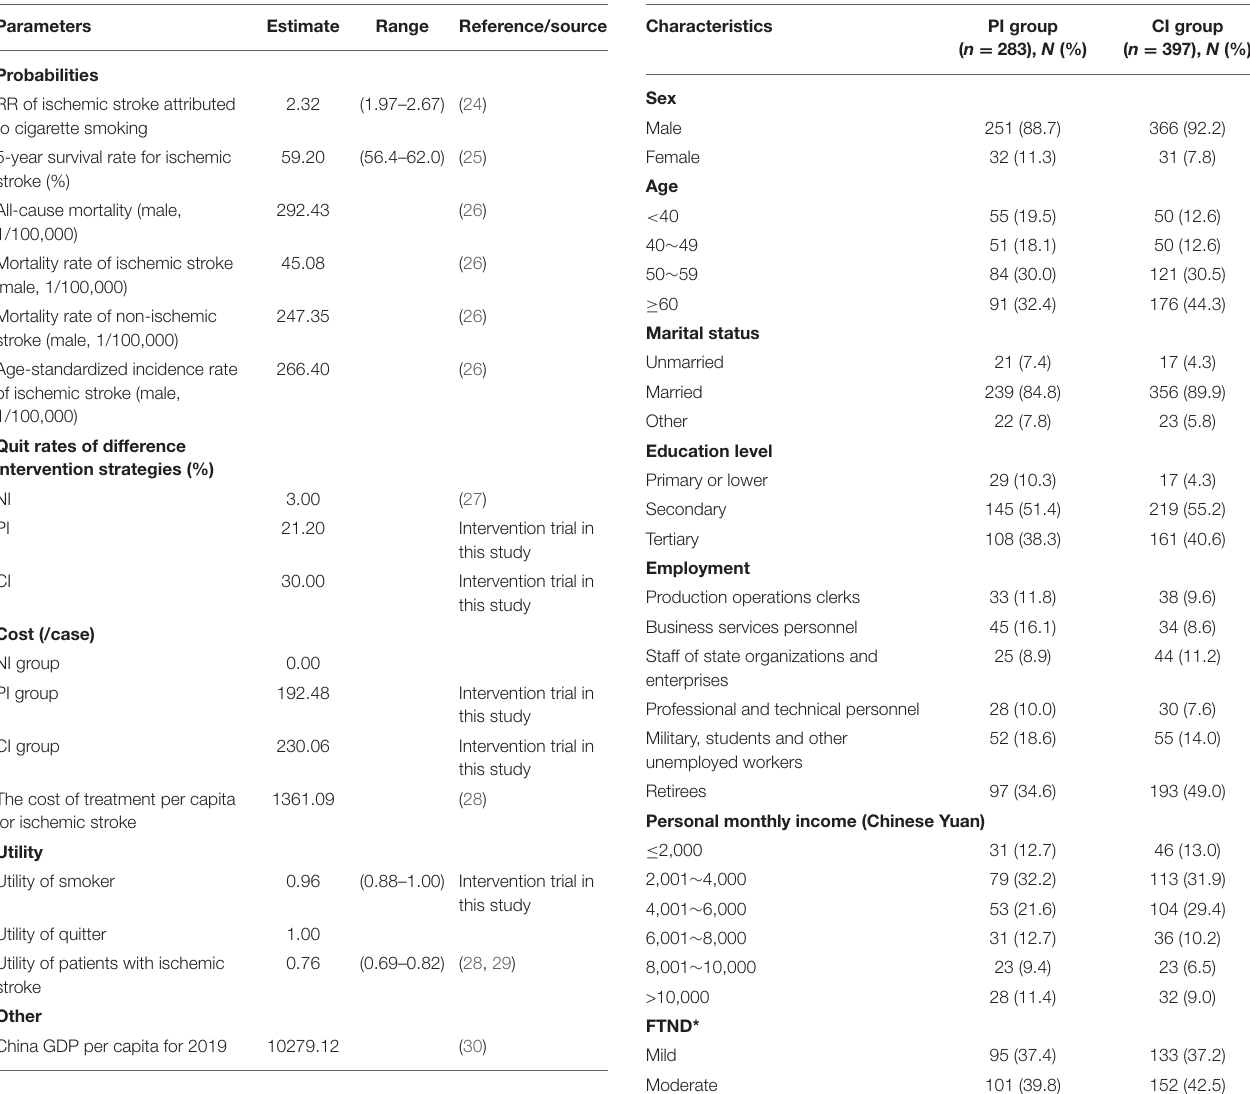
TABLE 1 | Decision-analytic model parameters. TABLE 2 | Baseline characteristics of